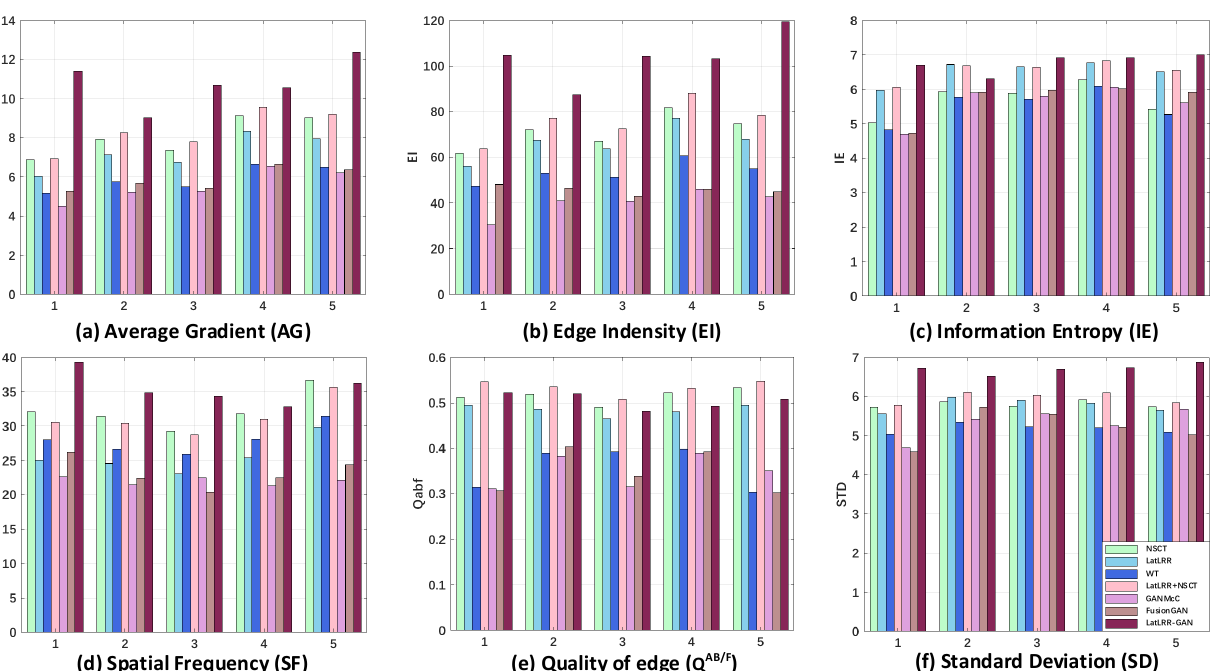
Figure 5. The fusion results of CT mediastinal window images and PET images. Method 1: NSCT; Method 2: LatLRR; Method 3: WT; Method 4: LatLRR+NSCT; Method 5: GANMcC; Method 6: Fu- sionGAN; Method 7: LatLRR-GAN.